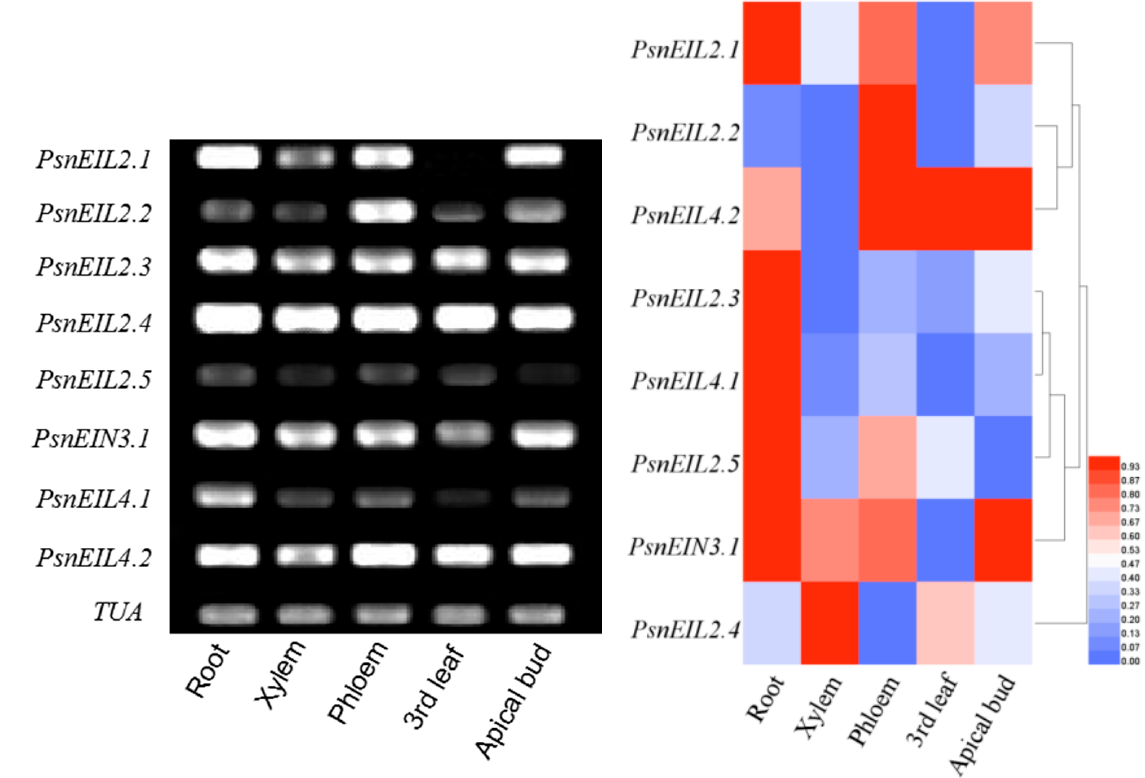
Figure 8. Tissue-specific expression pattern of PsnEIN3/EIL genes. The heat map shows the relative expression levels of EIN3/EIL genes in different plant parts (roots, xylem, phloem, third leaves, and terminal buds) of Populus × xiaohei.